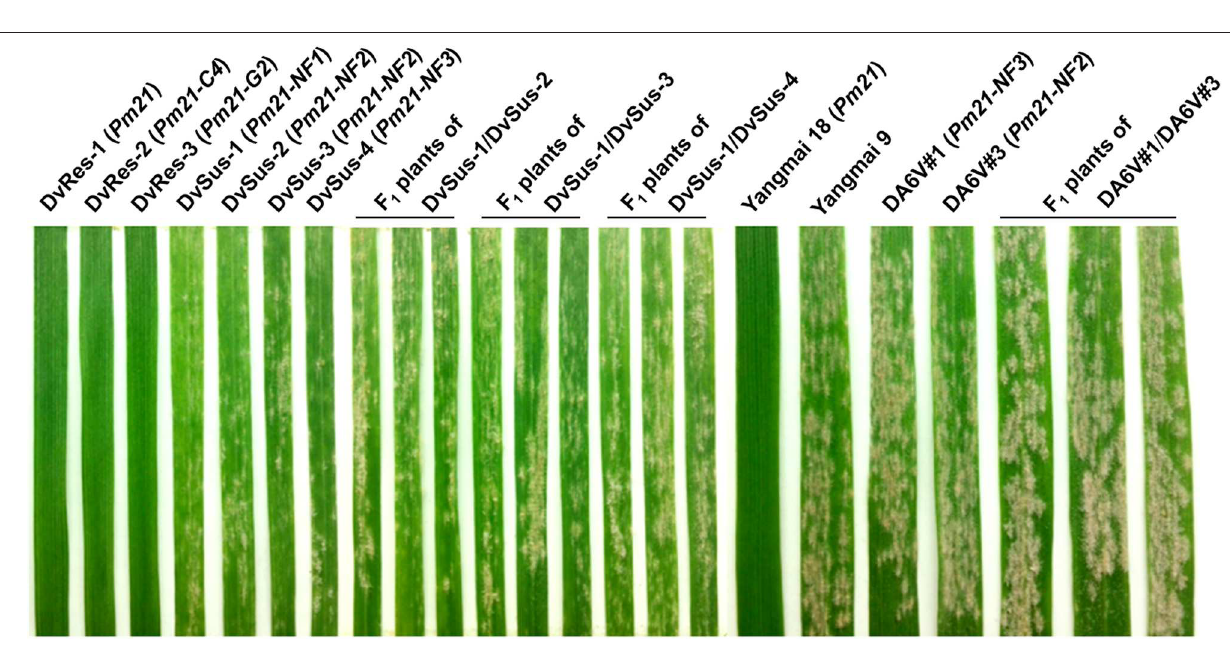
FIGURE 2 | Powdery mildew responses of different D. villosum lines, wheat genetic stocks, and F 1 plants of the crosses DvSus-1/DvSus-2, DvSus-1/DvSus-3, DvSus-1/DvSus-4, Dv6V#1/ Dv6V#3. The plants were inoculated with Bgt isolate YZ01 at one-leaf stage. The resistant wheat cv. Yangmai 18 and the susceptible cv. Yangmai 9 were used as the controls. Line DvRes-1 carries Pm21 . Lines DvRes-2 and DvRes-3, carrying Pm21-C4 and Pm21-G2 , were the resistant individuals of the accessions GRA961 and GRA1114, respectively. Lines DvSus-1 to DvSus-4, carrying non-functional Pm21 genes, were the susceptible individuals in the accessions GRA2738, GRA962, GRA1105, and PI598390,